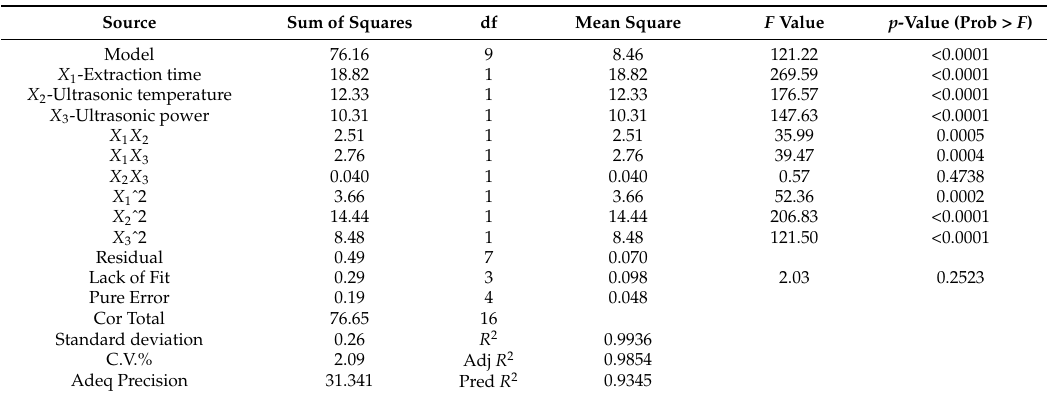
Figure 2. Model adequacy plots. Table 2. ANOVA for the response surface quadratic model.